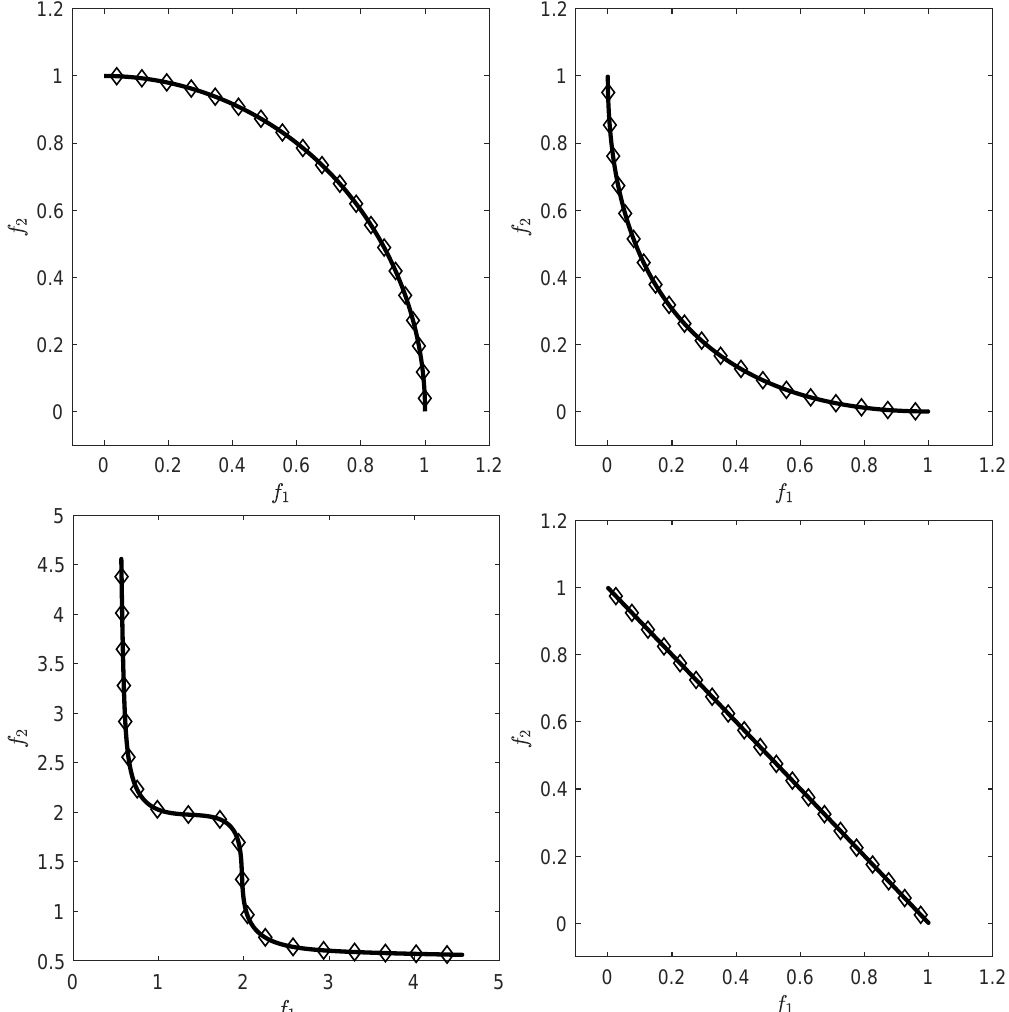
Figure 1. Pareto fronts with different shapes together with their best approximations in the sense of (5) for p = 2 and N = 20, and where Z is an approximation of the Pareto